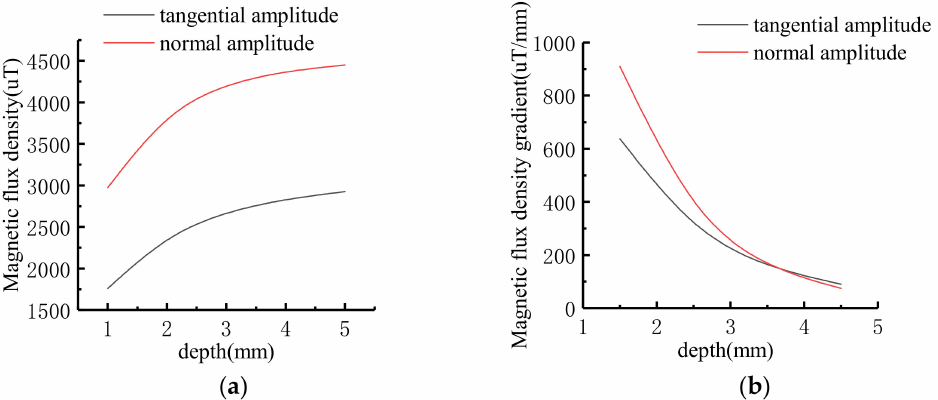
Figure 9. Variation trend of signal characteristics at different depths: ( a ) Signal variation curve; ( b ) Signal gradient variation curve.